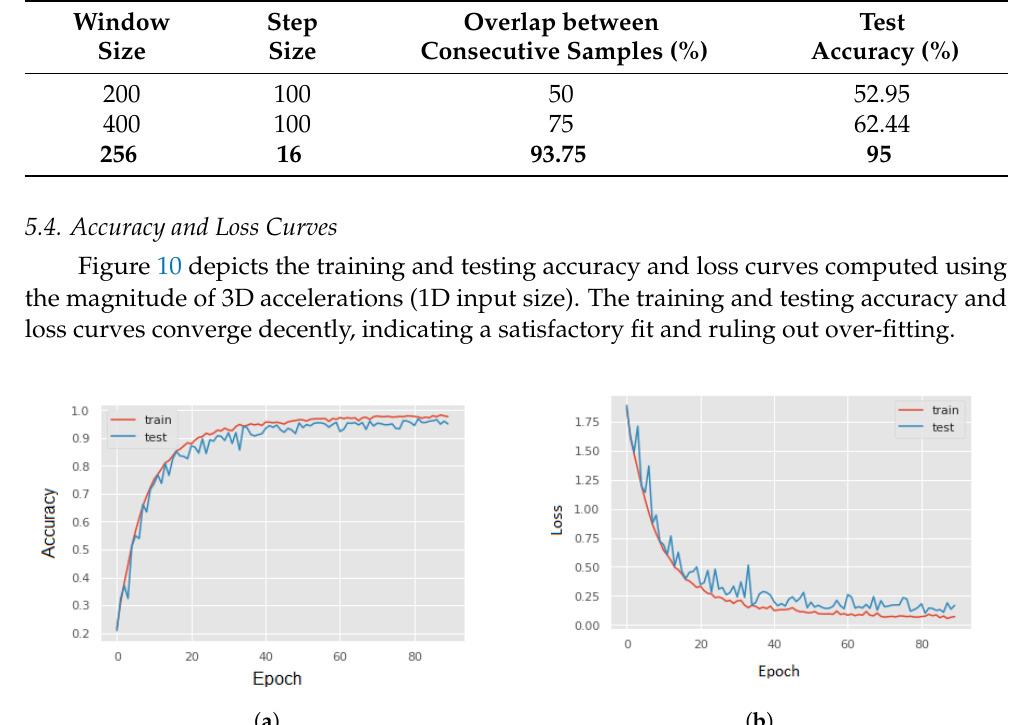
Table 3. Comparison of different segmentation window sizes and step sizes and their effect on test accuracies. A window size of 256 and a step size of 16 produce the best test accuracies.